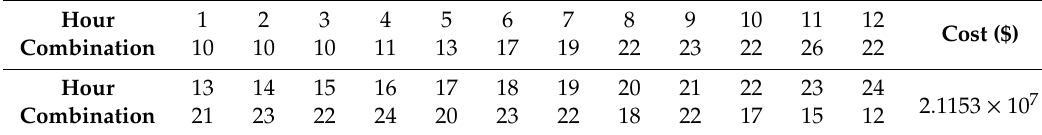
Table 6. Appropriate combination of units and total cost for energy